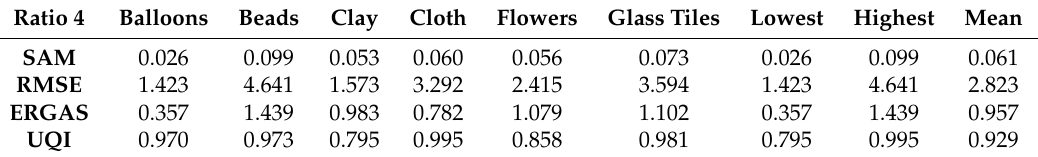
Table 2. Spectral quality indexes for the higher spatial resolution CAVE images trained with input of 128 × 128